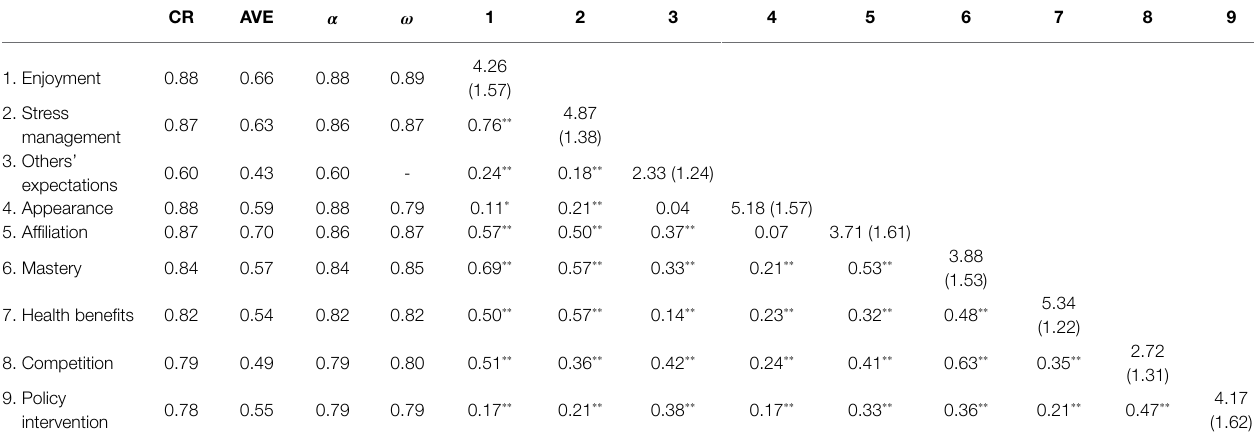
TABLE 6 | Composite reliability (CR), average variance extracted (AVE), Cronbach’s α , factor mean (SD), and factor correlation of final nine-factor model for the CUSPAMS. CR AVE α ω 1 2